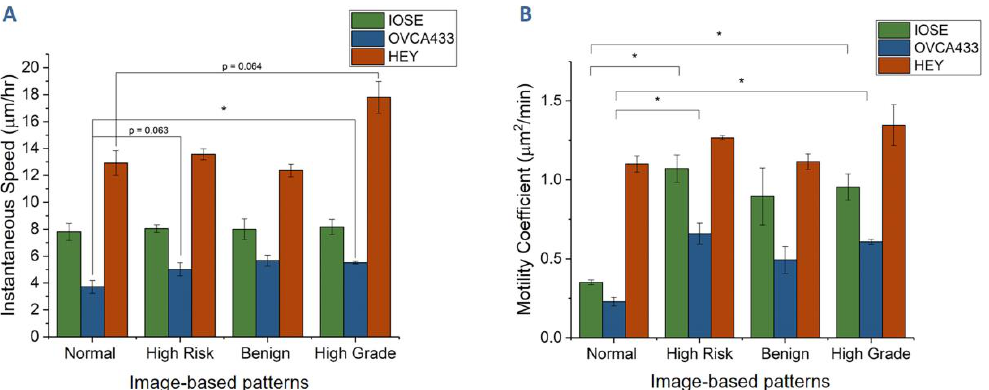
Figure 4. Migration dynamics for the three cell lines on scaffolds representing the four tissue types. ( A ) Instantaneous cell migration speed. ( B ) Motility coefficients. Migration was tracked over 72 h (* p < 0.05).